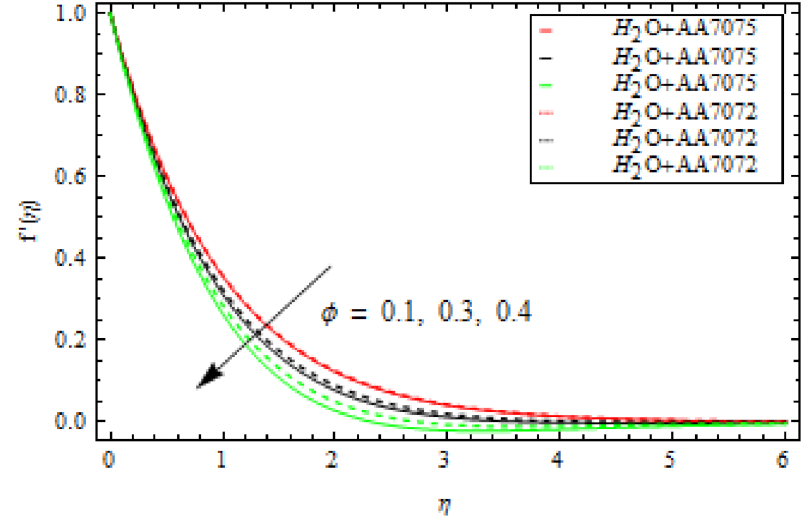
Figure 6. Influence of volume fraction φ on velocity